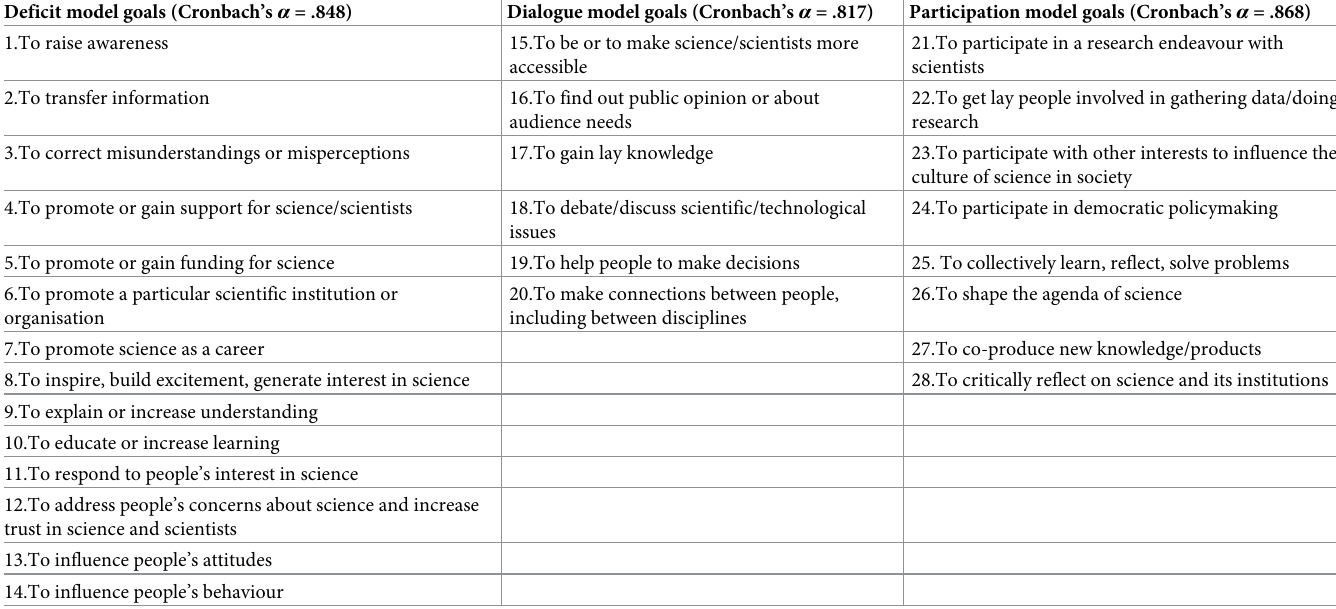
Table 1. General science communication goals and models. Deficit model goals (Cronbach’s α = .848)